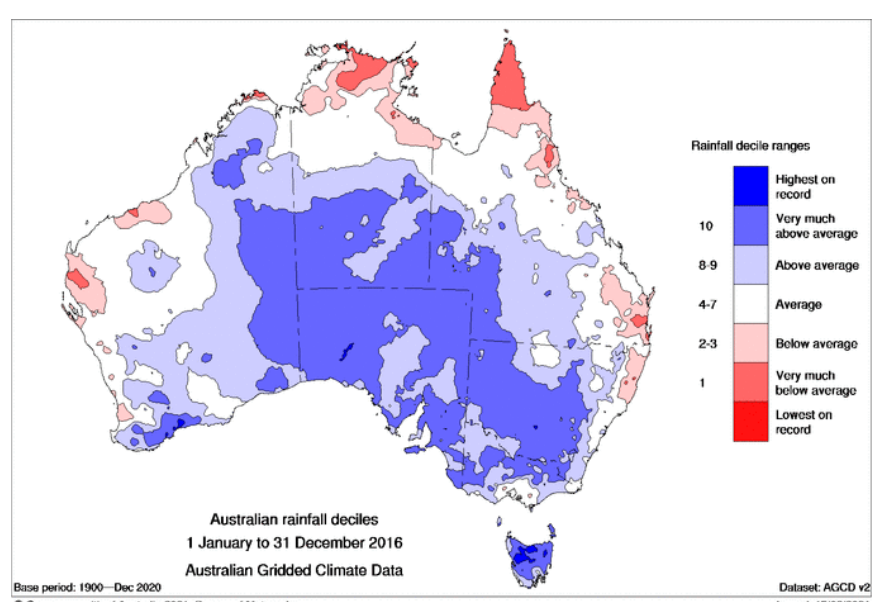
Figure A1. 2016 rainfall deciles in Australian continent. Source: Bureau of Meteorology